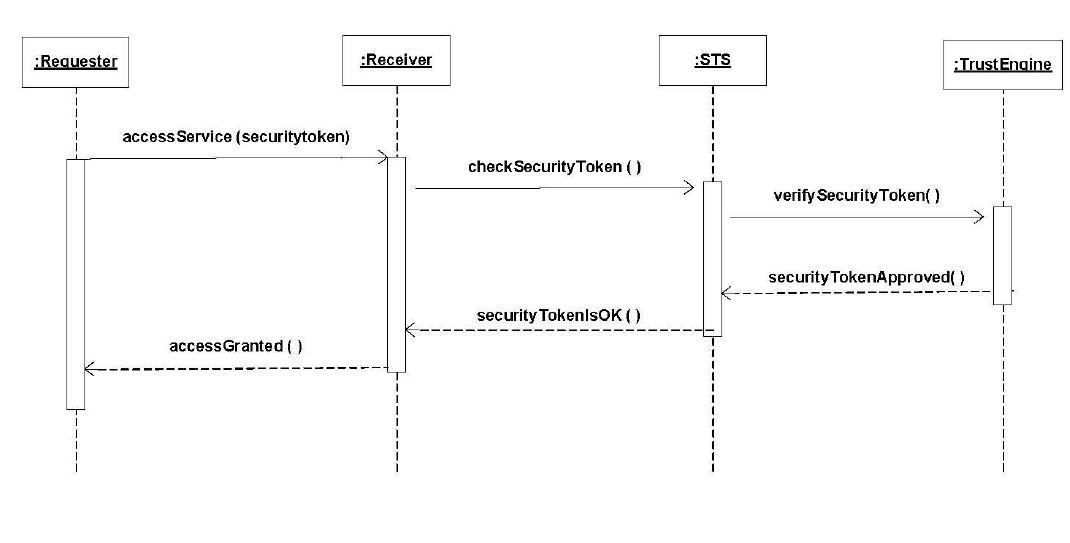
Figure 7. Sequence Diagram accessing a resource using a